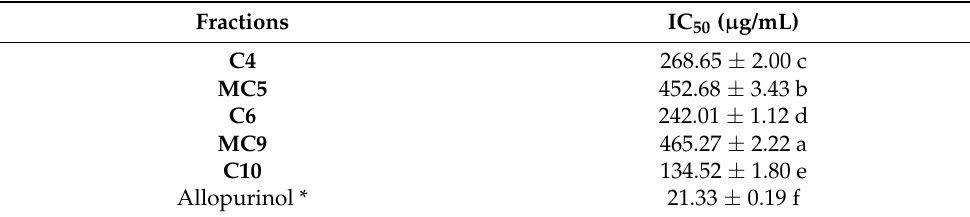
Table 5. Xanthine oxidase inhibitory activity of fractions isolated from kava root.